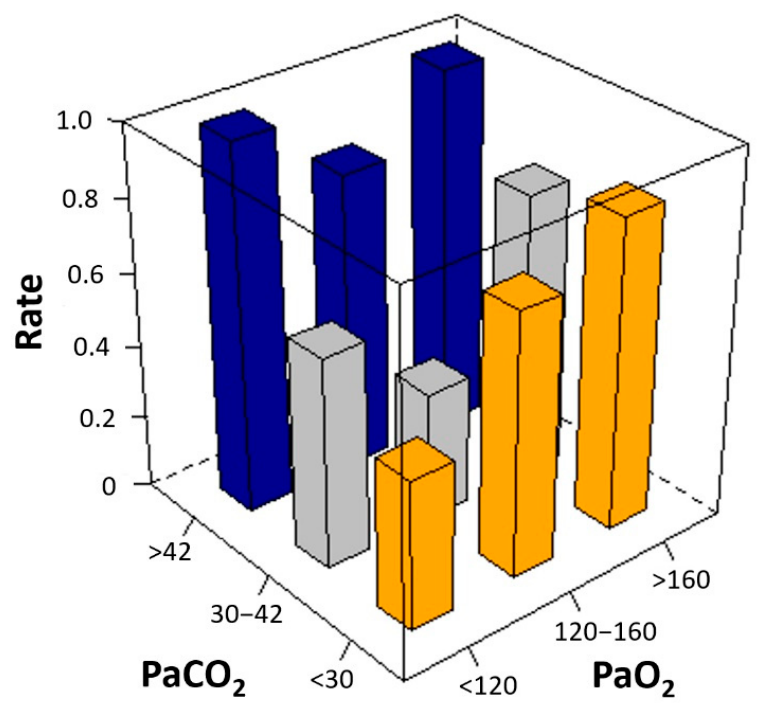
Figure 3. Unadjusted rate of poor neurological outcomes according to the mean levels of arterial carbon dioxide (PaCO 2 ) and arterial oxygen (PaO 2 ). Considering mean PaCO 2 and PaO 2 simultane- ously, the risk of poor neurological outcomes was lowest in patients with the second tertile of mean PaCO 2 and PaO 2 (the smallest gray square column in the middle).